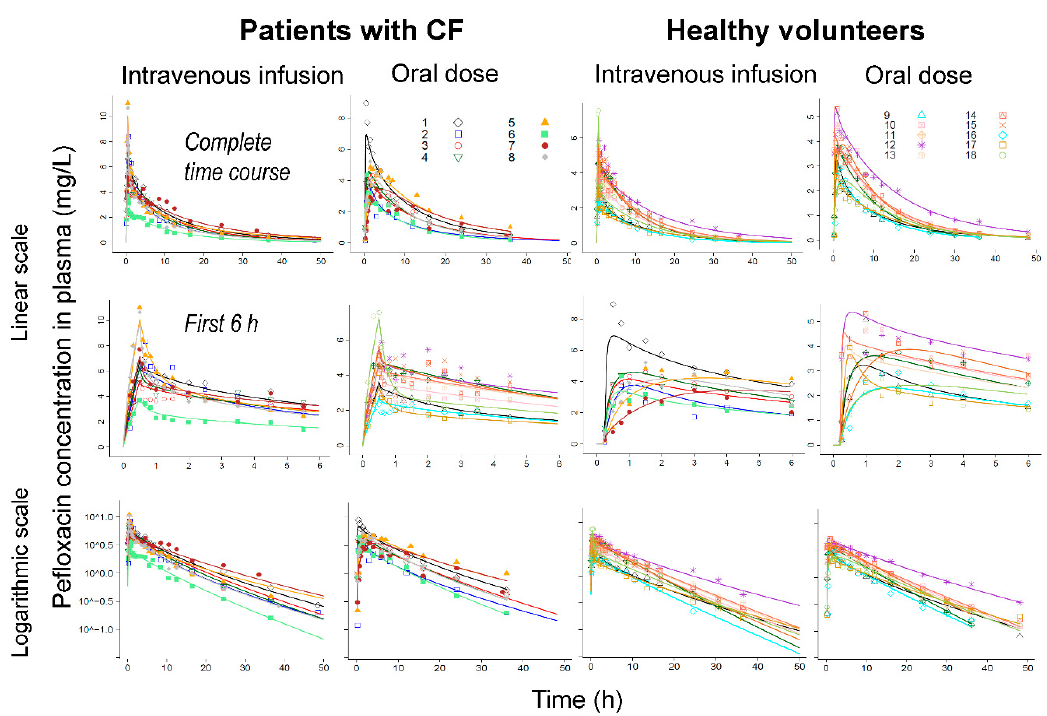
Figure 2. Observed (markers) and individually fitted plasma concentrations (lines) for pefloxacin in patients with CF (left) and healthy volunteers (right) on linear (top and middle rows) and logarithmic (bottom row) scale. The middle row represents the first 6 h on linear scale.